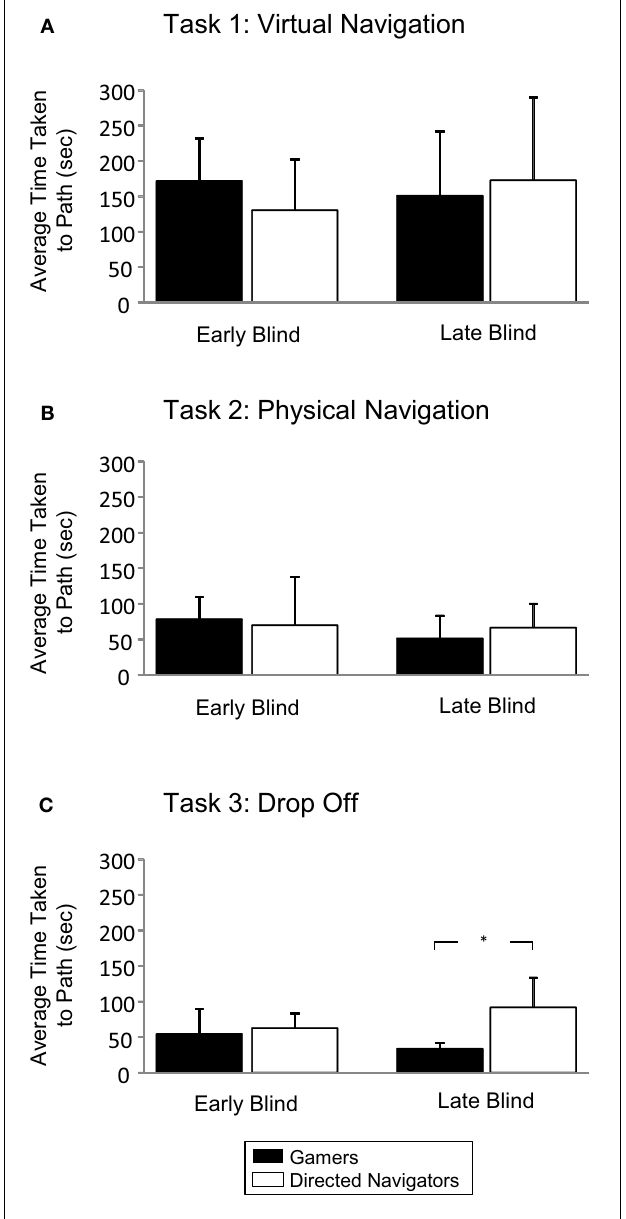
FIGURE 4 | Navigation performance—time to target. Average time taken to navigate to target in the virtual navigation task (A) and the physical navigation task (B) was also similar across groups. (C) For the drop off task, gamers were generally faster than directed navigators to reach their target using an alternate route; however the difference was only significant in the late blind group. The Three-Way ANOVA revealed a significant main effect for condition (see text). Error bars indicate SD, ∗ p < 0 .